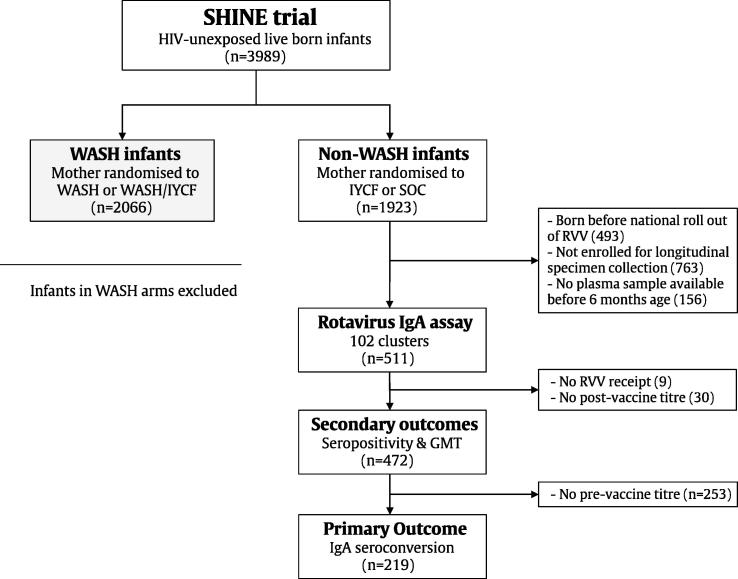
Consort flow diagram. The full trial flow, with additional detail, can be found in the Appendix, Fig. S1. WASH = Water, sanitation & hygiene; IYCF = infant & young child feeding; SOC = standard of care; RVV = rotavirus vaccine; GMT = geometric mean titre.